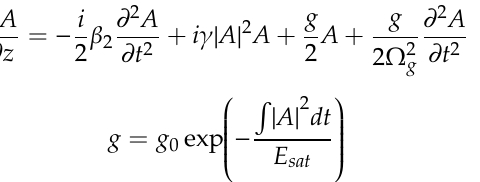
Figure 7. ( a , b ) Long-term stabilities of CS and NLP every 1 h sampling over 6 h.